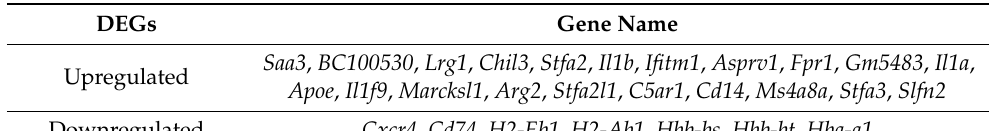
Table 1. A total of 28 DEGs were identified in macrophages subjected to force compared to control, including 21 upregulated genes and 7 downregulated genes.